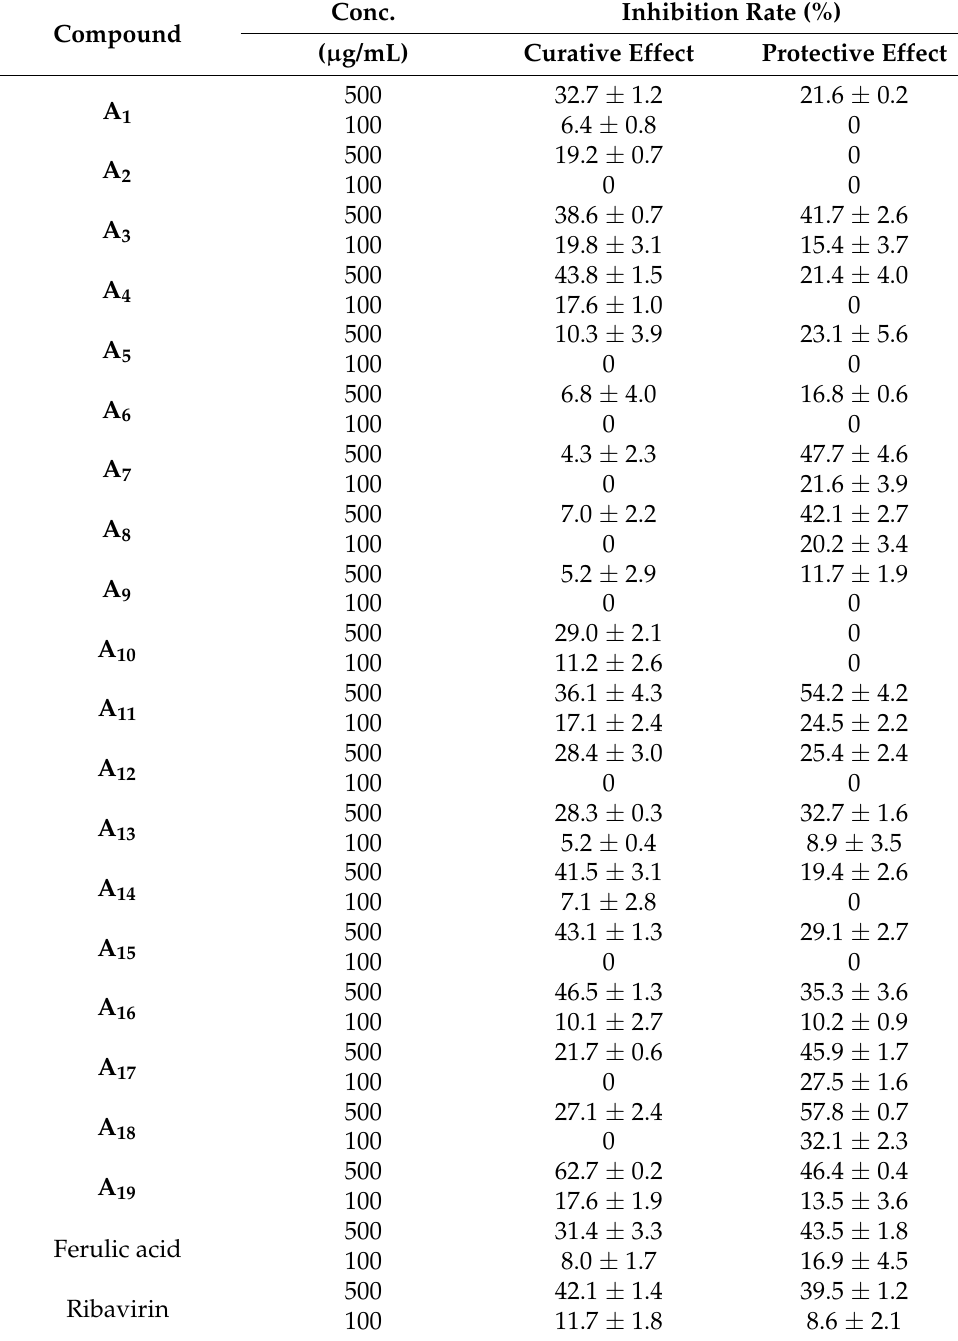
Table 1. The in vivo anti-TMV activity of synthesized compounds ( A 1 – A 19 ).